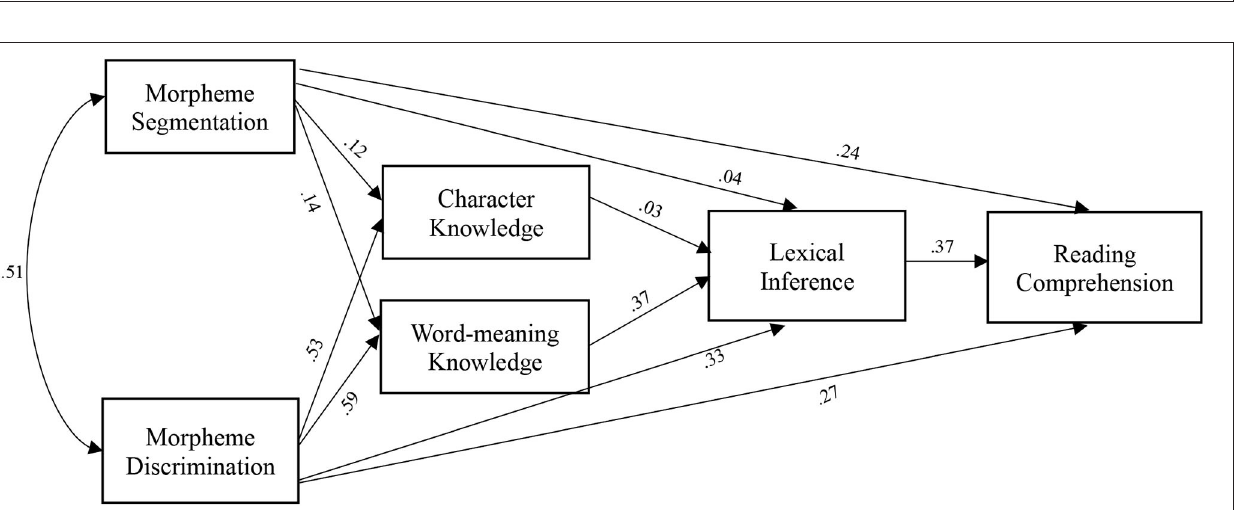
FIGURE 2 | Model 2 hypothesizing the mediation through vocabulary knowledge and lexical